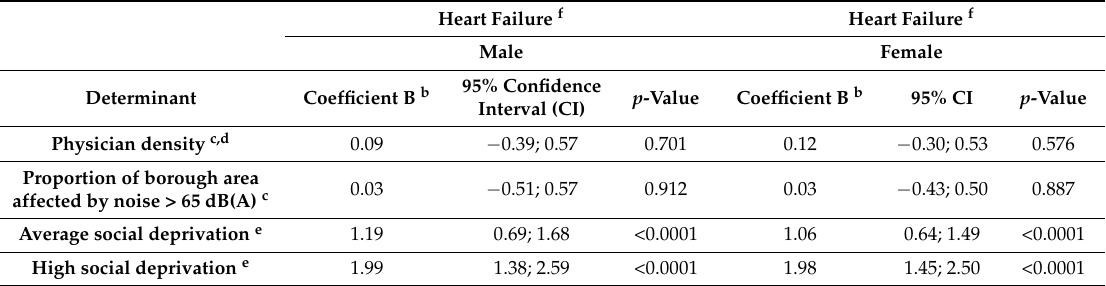
Table 4. Associations of determinants on heart failure, Hamburg, Germany a